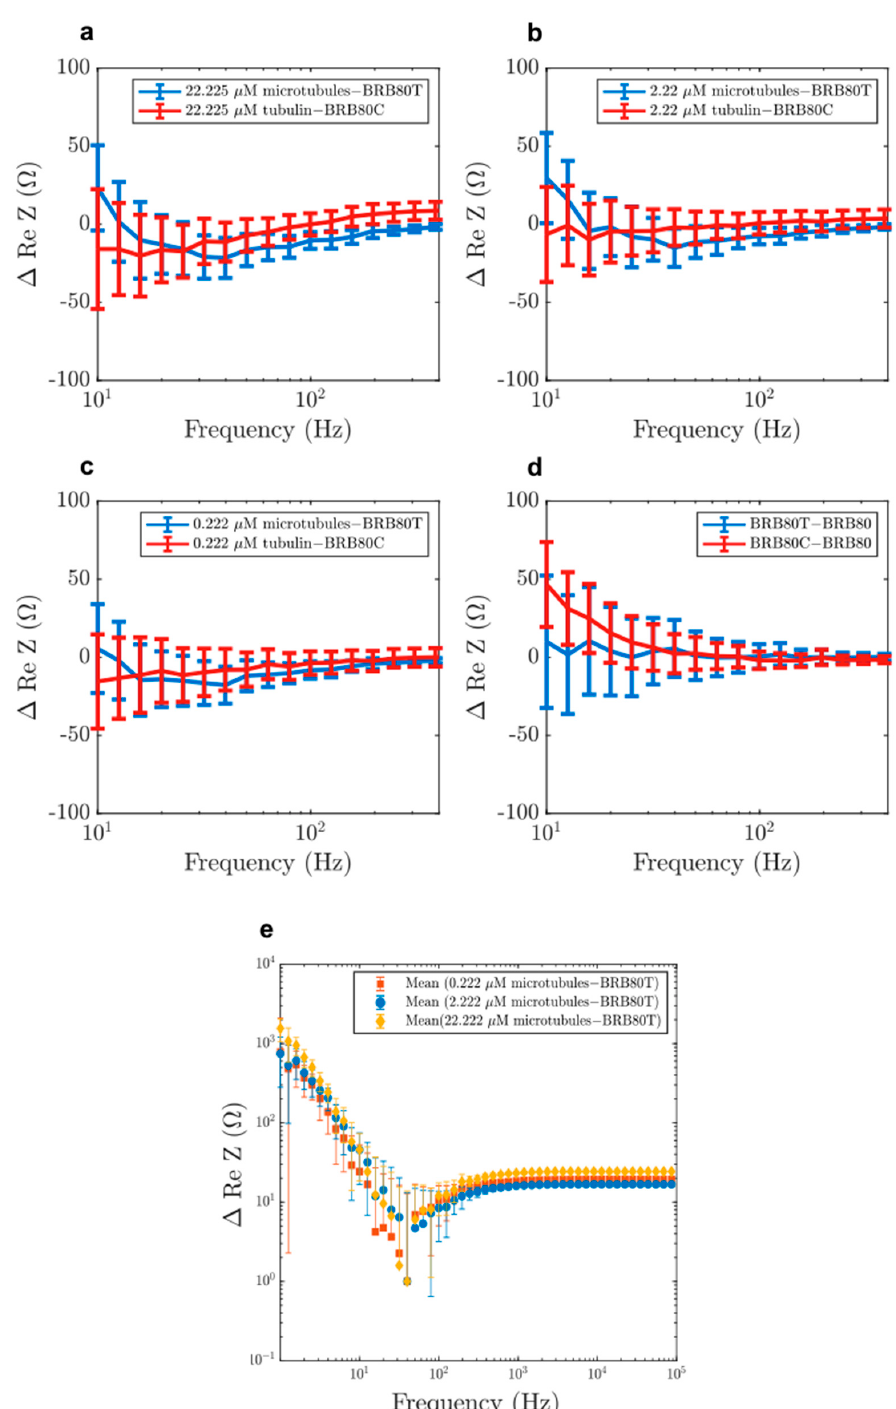
Figure 6. Zoomed in view of the mean differences in the real component of impedance as a function of decreasing input AC frequency at total tubulin concentrations of ( a ) 22.225 μ M, ( b ) 2.222 μ M, ( c ) 0.222 μ M, ( d ) comparison of the effect of paclitaxel and colchicine on impedance. ( e ) A logarithmic plot obtained by translating the graphs (a), (b) and (c) upwards. The translation is performed by adding (1 + minimum MT solution resistance) to the resistance of each MT concentration. A resistance reversal between 20–60 Hz is observed, with a peak at 39 Hz for the 22.225 µ M concentration. Error-bars represent standard